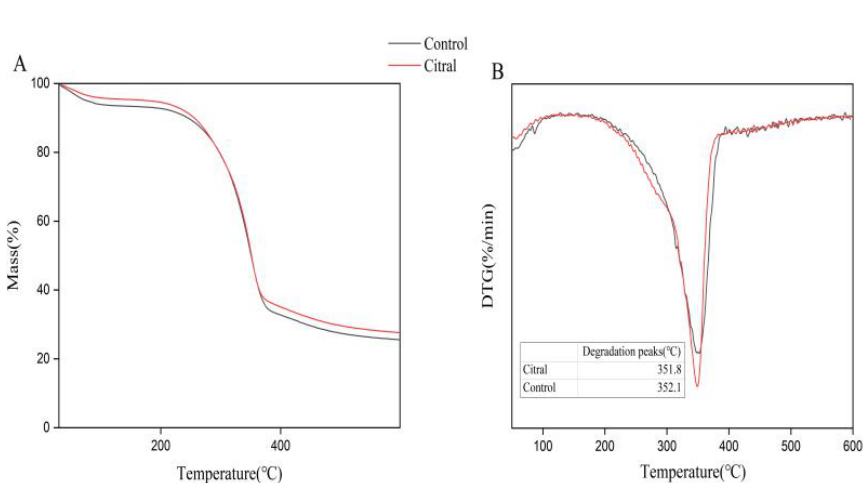
Figure 5. ( A ) TG curves of chitin in the control and citral-treated groups; ( B ) DTG profiles of the